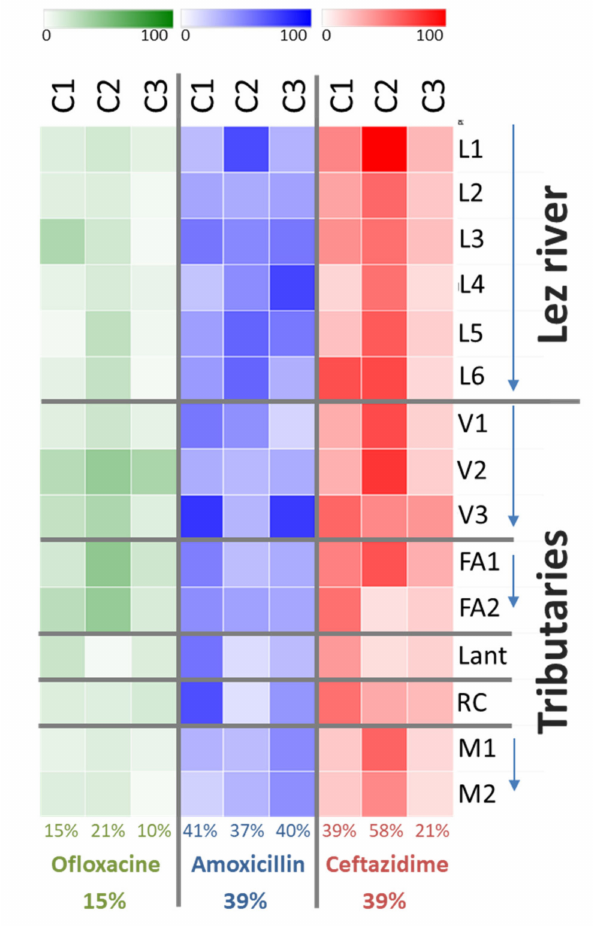
Figure 4. Heatmap showing the percentages of cultivable communities resistant to ofloxacin, amoxi- cillin and ceftazidime at every sampling site and campaign. Each line corresponds to a sampling site. Campaign numbers (C1, C2, and C3) are indicated on the top while antibiotics are noted at the bot- tom. Percentages under the heatmap correspond to the mean rate of resistance. Percentages in bold correspond to the mean resistance of the 3 campaigns. Arrows represent water flow direction. L1 to L6: Lez River; V1 to V3: Verdanson River; FA1 and FA2: Font d’Aurelle River; Lant: Lantissargues River; RC: Rieu Coulon River; M1 and M2: Mosson